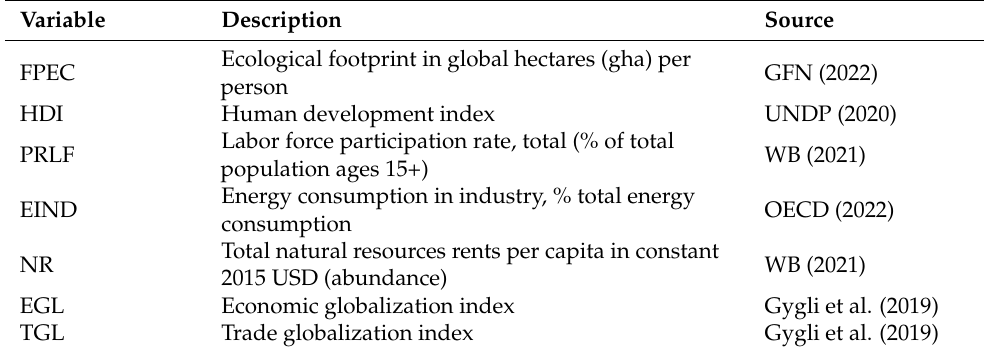
Table 1. Variables and data sources.